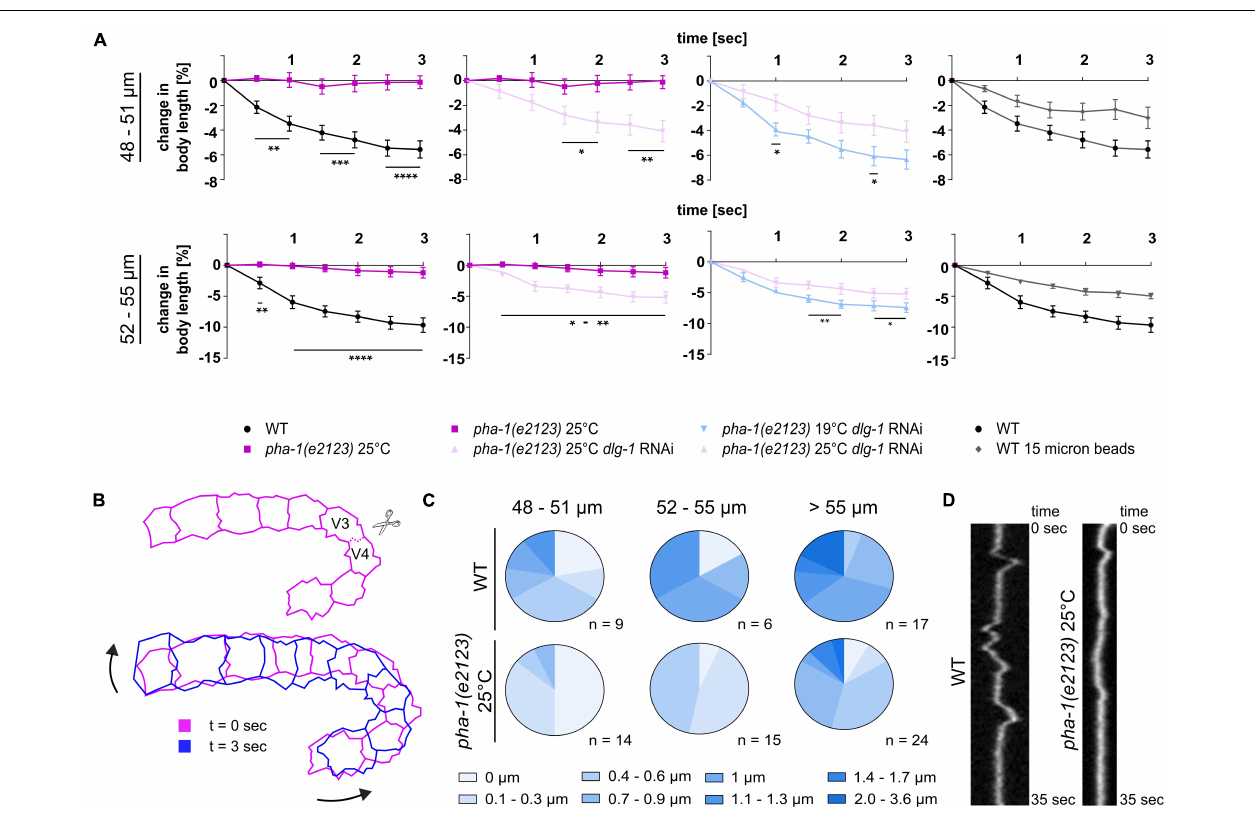
FIGURE 6 | Tissue biomechanics are altered in pha-1(e2123) embryos. (A) Normalized quantification of body retraction post ablation for WT and pha-1(e2123) embryos of varying length (48–55 µ m, length: anterior side H0 – posterior side V5) maintained either at the non-permissive temperature of 25 ◦ C or at the threshold temperature of 19 ◦ C with or without dlg-1 feeding RNAi. Panel furthest to the right: Comparison of body retraction between WT embryos mounted with 20 or 15 µ m microspheres (SEM, n = 5–7). (B) Scheme of movements observed post laser ablation. Top: Cell boundary within the lateral line of seam cells cut during laser ablations. Bottom: Changes in orientation of seam cells before ( t = 0 s) and after ablation ( t = 3 s). Arrows indicate direction of movement of cell sheet. (C) Quantification of twitching intensities of WT and pha-1(e2123) embryos of varying length ( ≥ 48 µ m). (D) Representative kymograph of cell boundary deflection in WT and pha-1(e2123) embryos. T-test: * p < 0.05; ** p < 0.01; *** p < 0.001; and **** p <